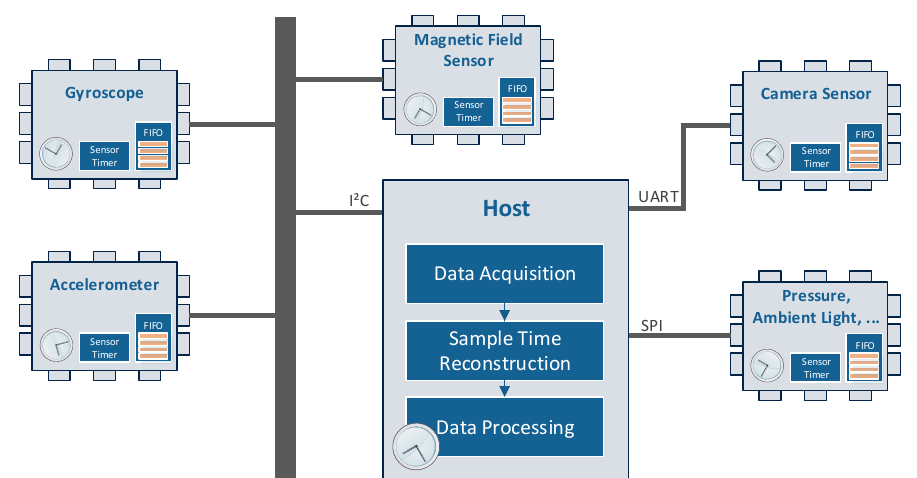
Figure 2. Architecture: sensor devices are directly connected to the host. They support a sensor timer and a first-in-first-out (FIFO) storage. Due to drift effects, each system runs on a different timebase.